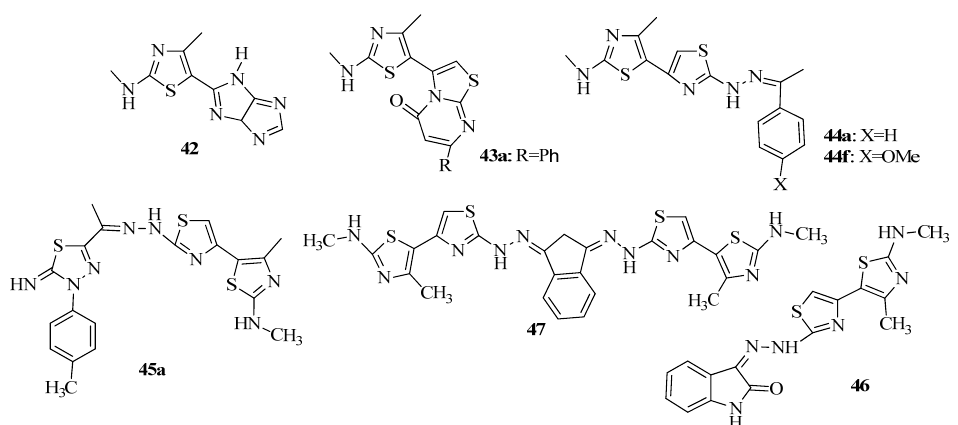
Figure 16. Structures of (Z)-N,4 ′ -dimethyl-2-(2-(1-phenylethylidene)hydrazinyl)-[4,5 ′ -bithiazole]- 2 ′ -amine, derivatives, 2-(2-(1-(5-imino-4-(p-tolyl)-4,5-dihydro-1,3,4-thiadiazol-2- yl)ethylidene)hydrazinyl)-N,4 ′ -dimethyl-[4,5 ′ -bithiazole]-2 ′ -amine, ( Z )-3-(2-(3-(4-methyl-2- (methylamino)thiazol-5-yl)cyclopenta-1,3-dien-1-yl)hydrazono)indolin-2-one, 2,2 ″ -((2Z,2 ′ Z)-2,2 ′ - (1H-indene-1,3(2H)-diylidene)bis(hydrazin-1-yl-2-ylidene))bis(N,4 ′ -dimethyl-[4,5 ′ -bithiazole]-2 ′ - amine).